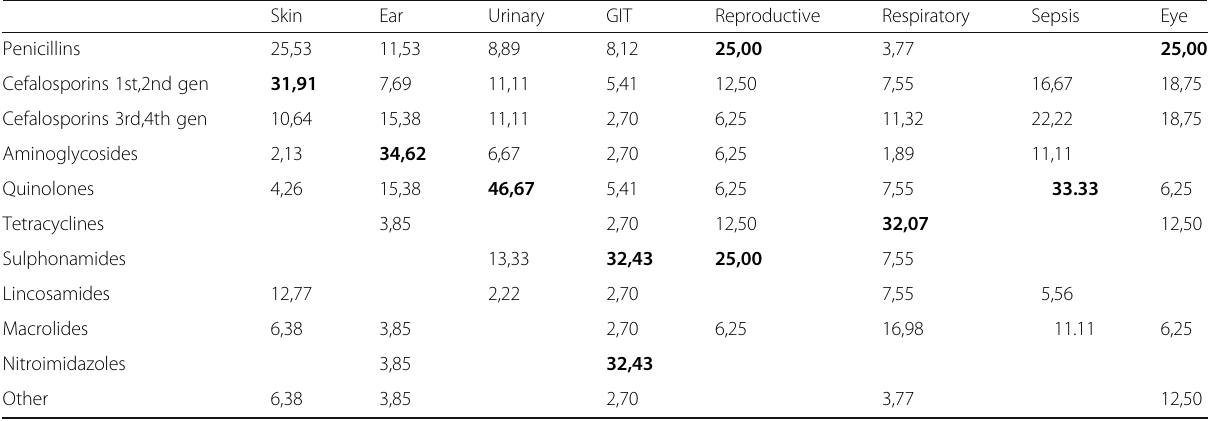
Table 2 Percentage of respondents ’ type of antimicrobial usage for different organs systems. The cells in bold represent the first- choice antimicrobial for every organ system Skin